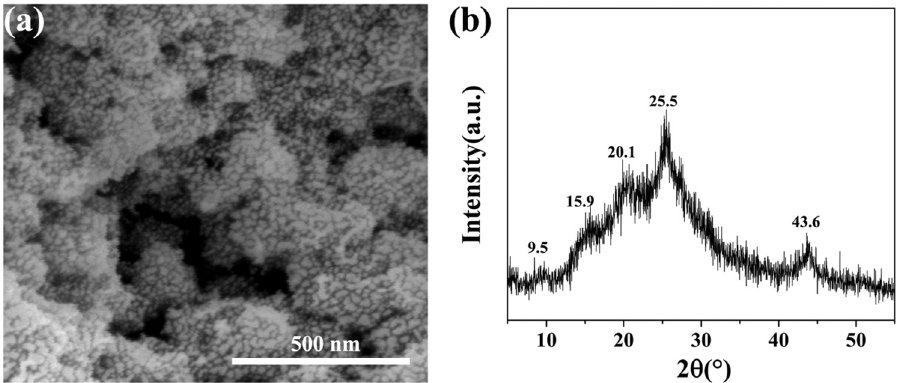
Figure 1: ( a ) SEM image and ( b ) XRD pattern of the polyaniline - modi fi ed ND